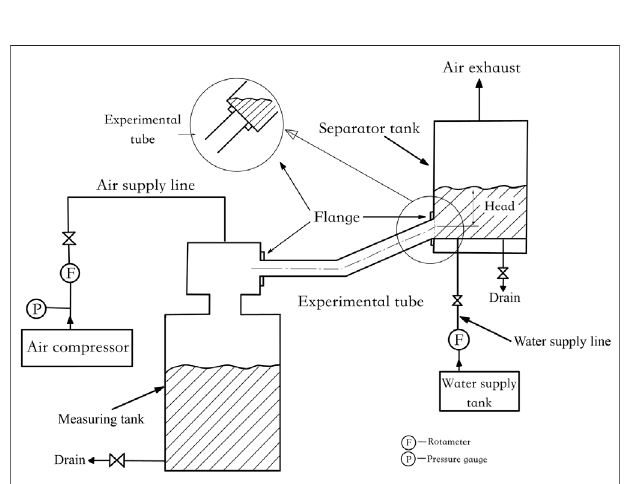
FIGURE 2 | Schematic of experimental setup (Ohnuki, 1986).